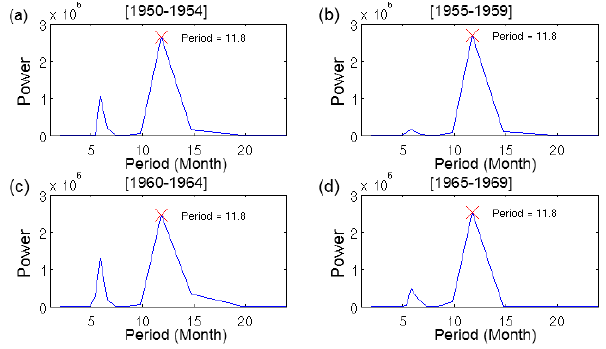
Fig. 22. Periodicities around 1960 in Narok estimated from the rep- resentative time series of the harmonics. (a) shows the periodicities between 1950 and 1954, (b) between 1955 and 1959, (c) between 1960 and 1964, and (d) between 1965 and 1969. The red cross mark means the major periodicity in each time region.